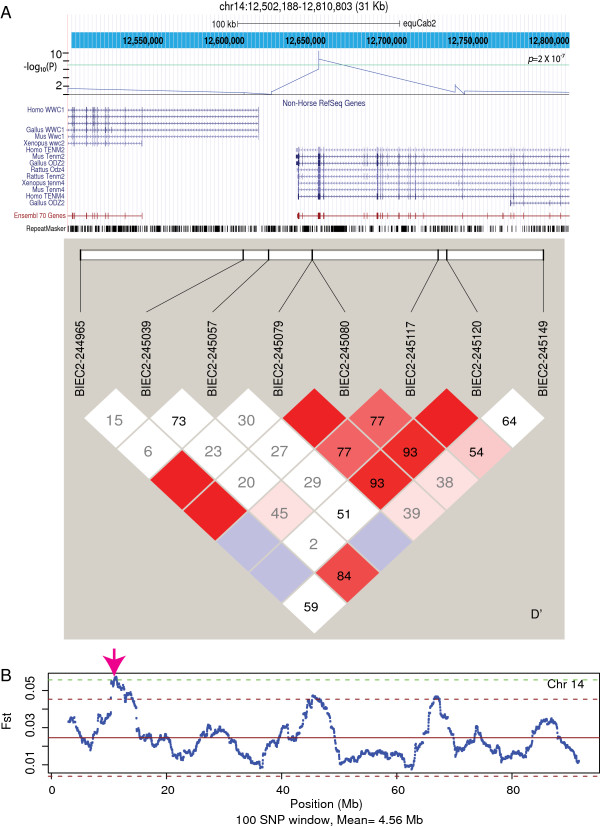
The most significant allelic frequency divergence found in this study between feral Andean horses and the comparison group within the TENM2 gene. A The arrangement of TENM2 genes from different species is shown from the UCSC browser along with the –log (p-value) for individual SNPs in the region. The green line represents genome wide significance. Linkage disequilibrium between adjacent SNPs (D’) is shown the browser graph. B shows the Fst nalysis of Chromosome 14 with the region of TEMN2 indicated (arrow). The green dotted line represents 2 standard deviations from the mean Fst value for chromosome 14.